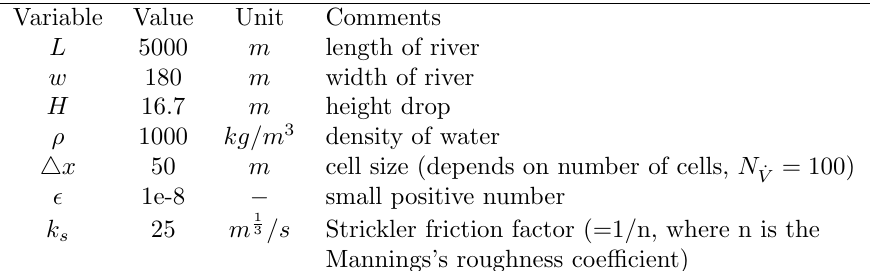
Table 1: Parameters of the river flow system.